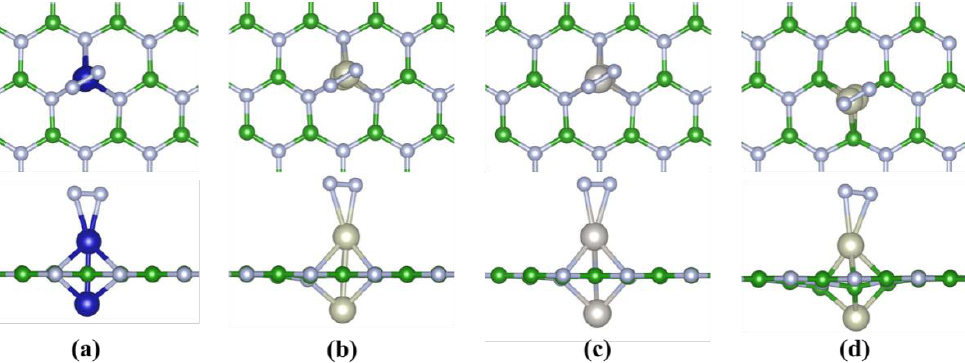
Figure 4. Optimized geometries of N 2 adsorption on ( a ) Co 2 ⊥ vb-BN, ( b ) Rh 2 ⊥ vb-BN, ( c ) Pt 2 ⊥ vb-BN and ( d ) Rh 2 ⊥ vn-BN.